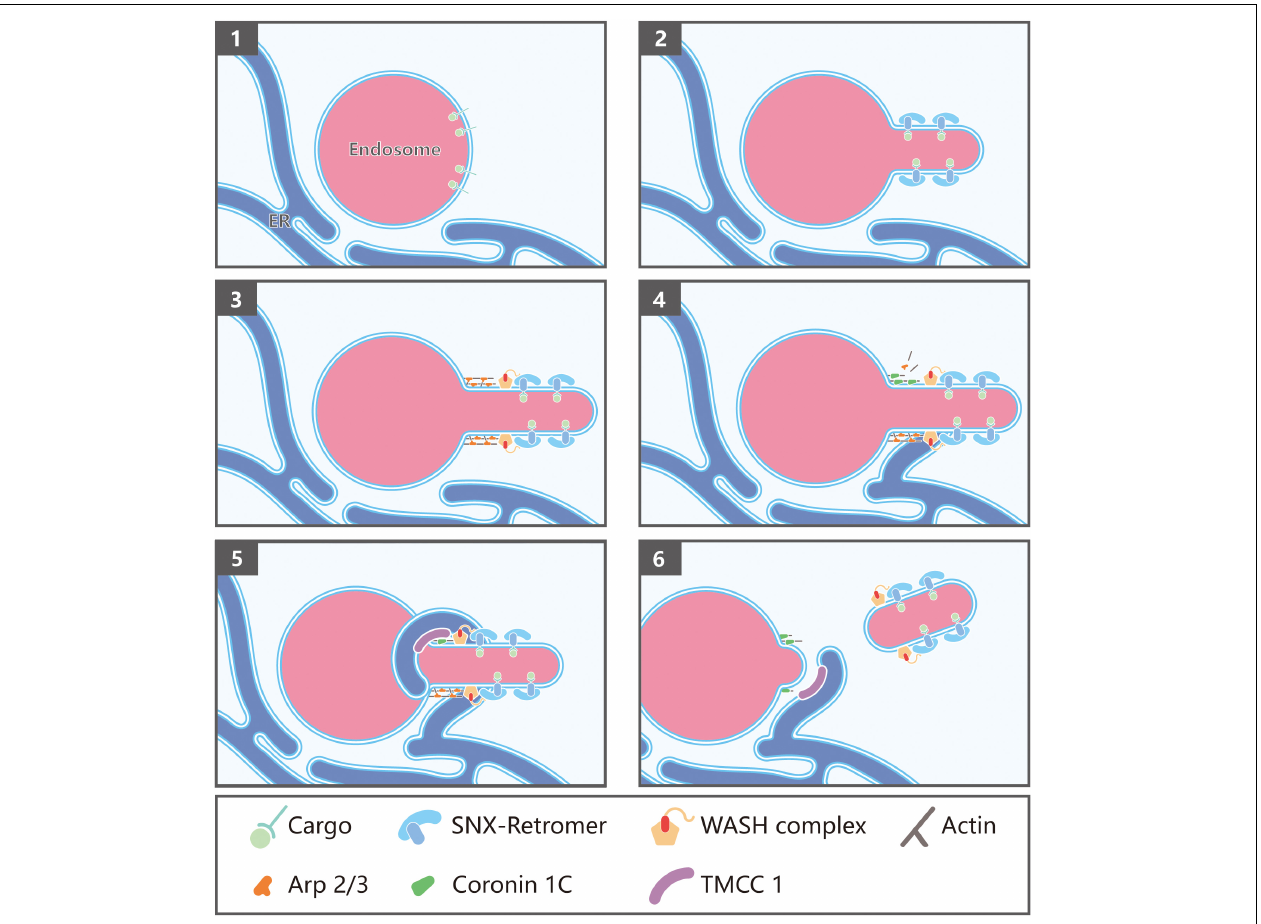
FIGURE 2 | Endoplasmic reticulum (ER)-endosome membrane contact sites in endosome fission: (1) Endosomes contain internalized transmembrane proteins or proteins delivered from the Golgi; (2) protein complexes, such as SNXs and retromer, recognize and concentrate specific cargo, and promote membrane remodeling; (3) retromer recruits the WASH complex via a direct interaction with the FAM21 subunit, which in turn promotes the assembly of branched actin via Arp2/3; (4) Coronin 1C associates with Arp2/3-mediated actin patches present on endosome buds; (5) Coronin 1C interacts with the ER membrane protein TMCC1 in order to recruit the ER to the Coronin 1C-labeled endosomal domains; (6) endosome fission occurs, likely via fission factors whose identity remains to be determined. Possible candidates include Dynamin2 and the EHD family